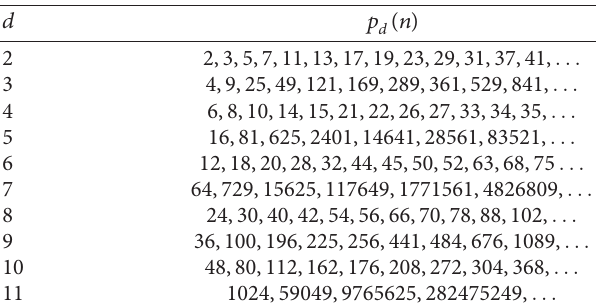
Table 1: Sequences of d -primes, denoted by p d ∈ 2 , 3 , .. . , 11 { } .